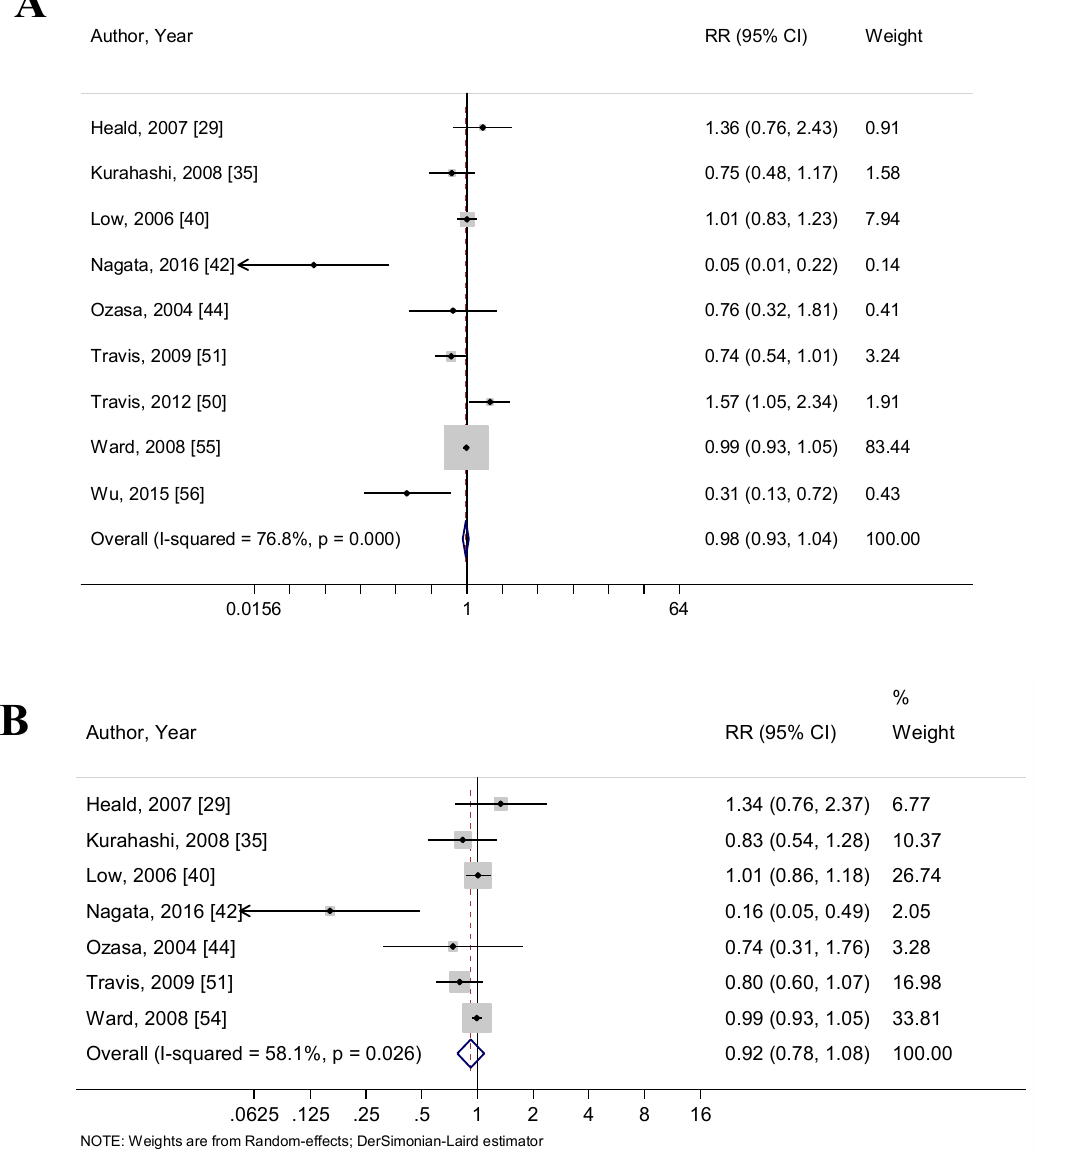
Figure 3. Forest plots for ( A ) circulating genistein and risk of prostate cancer; and ( B ) circulating daidzein and risk of prostate cancer. These associations were indicated as a relative risk (RR) estimate with the corresponding 95% confidence interval